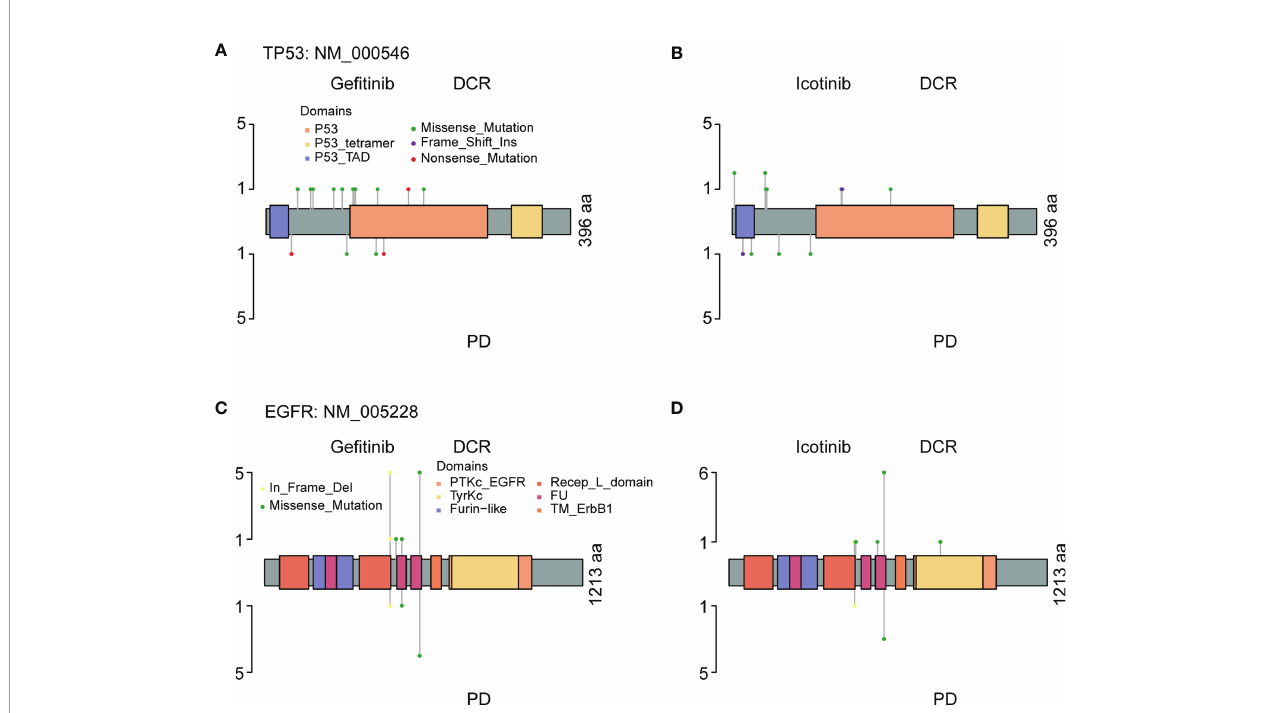
FIGURE 7 | The protein structure, mutation types, and mutation distributions of TP53 (A, B) and EGFP (C, D) in the patients with EGFR&TP53 co-alterations who were fi rst treated with Ge fi tinib (A, C) and Icotinib (B, D)